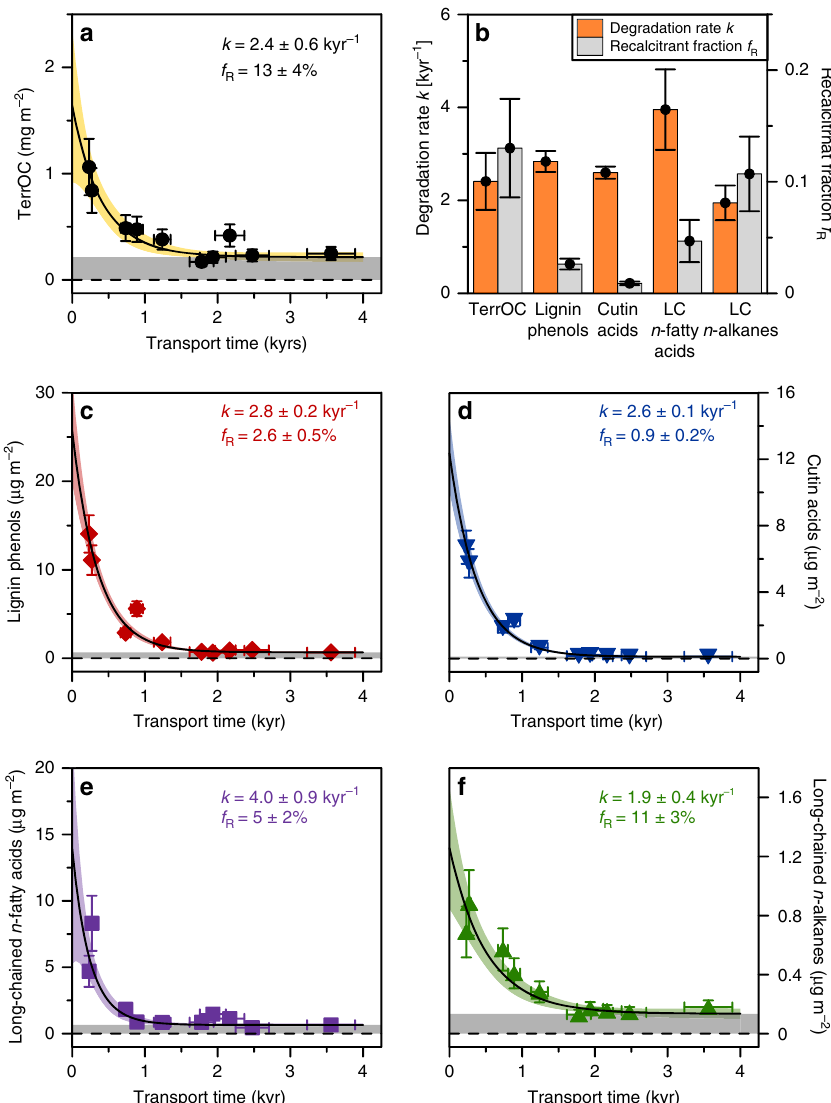
Fig. 3 Degradation rates and recalcitrant fractions for different terrOC pools. An exponential decay curve C t ð Þ ¼ C 0 ð Þ ´ e (cid:2) kt þ R is fi tted to measured loadings ( fi lled symbols in a , c – f , error bars correspond to ± 1 σ uncertainties) in surface sediments vs. transport time (calculated from the age-depth relationship, Fig. 2). Displayed curves (black lines in panels a , c – f ) and uncertainty ranges of the fi t (shaded area correspond to ± 2 σ in panels a , c – f ) for all parameters were determined by Monte Carlo simulations. The gray areas in panels a , c – f mark the positive offset C t ! 1ð Þ ¼ R , from which the recalcitrant fraction f R is calculated as f R ¼ R = C 0 ð Þ . a TerrOC fraction of total organic carbon loadings as calculated with dual-carbon isotope source apportionment. b Comparison of the different fi rst-order degradation rates k and recalcitrant fractions f R , derived in a , c – f . c – f Terrestrial biomarker loadings for the fi ne sediment fraction (<63 µ m, see Methods section on bulk organic carbon and biomarker analyses and Supplementary Information Fig. 5 for details): lignin phenols ( c ), cutin acids ( d ), long-chain n -fatty acids ( e ), and long-chain n -alkanes ( f